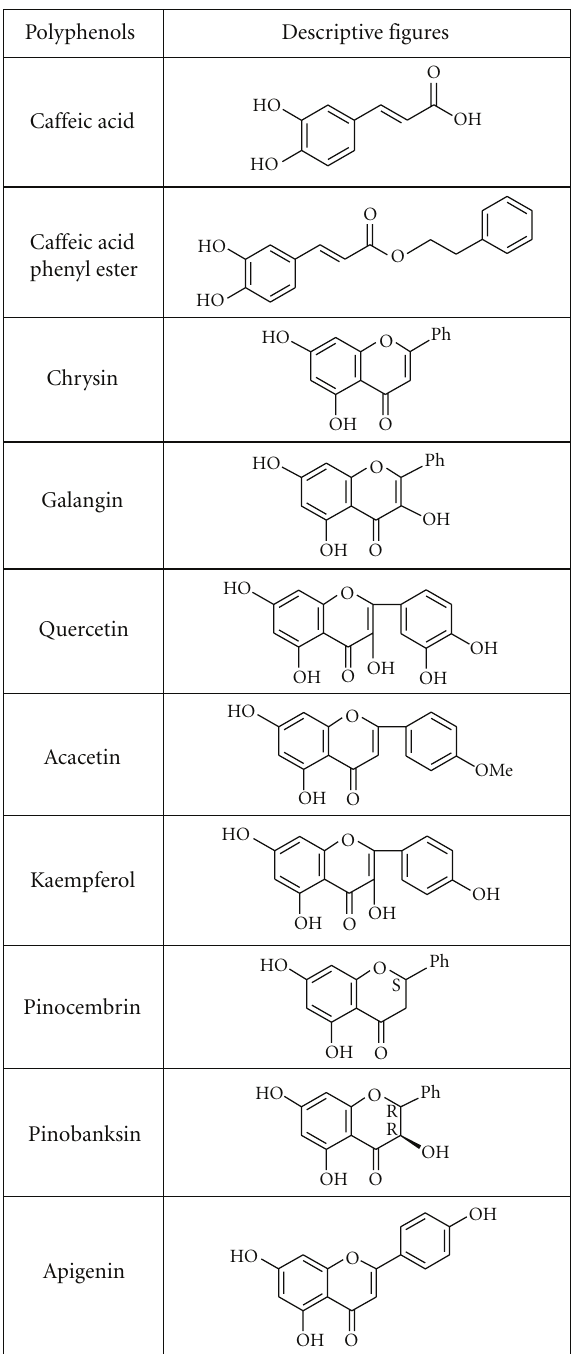
Table 1: Molecular representation of Polyphenols found in the